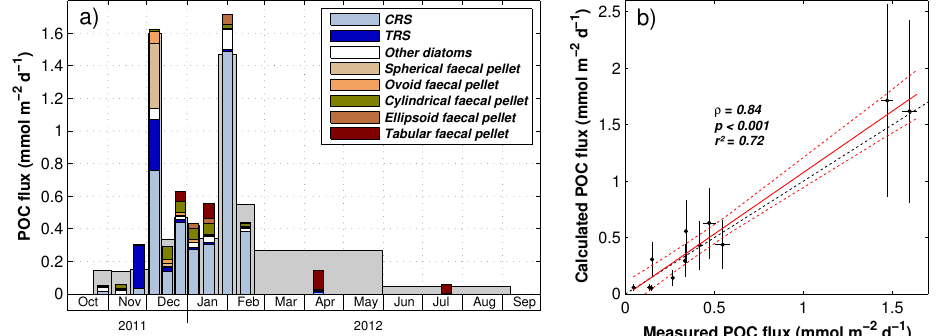
Figure 8. (a) Grey bars in the background are measured POC fluxes, and coloured bars in the foreground are calculated POC fluxes partitioned among the main ecological vectors identified. (b) Regression ( r 2 = 0.72) between the measured and calculated POC fluxes. The correlation is highly significant (Spearman rank correlation, n = 36, ρ = 0.84, p <0.001). Error bars were generated by increasing/decreasing the car- bon/volume conversion factors by 50%. Black dashed line is the 1 : 1 relation, red line is the regression line, and red dashed lines denotes the 99% confidence interval. CRS Chaetoceros Hyalochaete resting spores; TRS: Thalassiosira antarctica resting